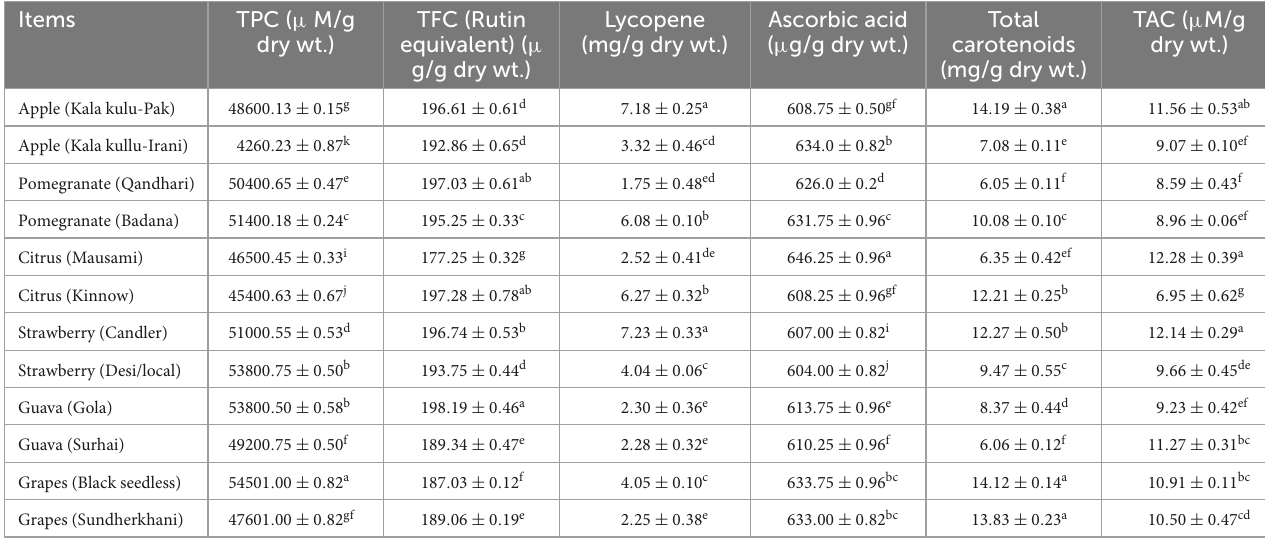
TABLE 1 The non-enzymatic antioxidant status of different fruit peel varieties. Items